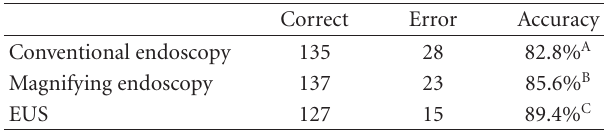
Table 4: Comparison of diagnostic accuracy among 3 di ff erent endoscopic techniques after excluding lesions with inadequate